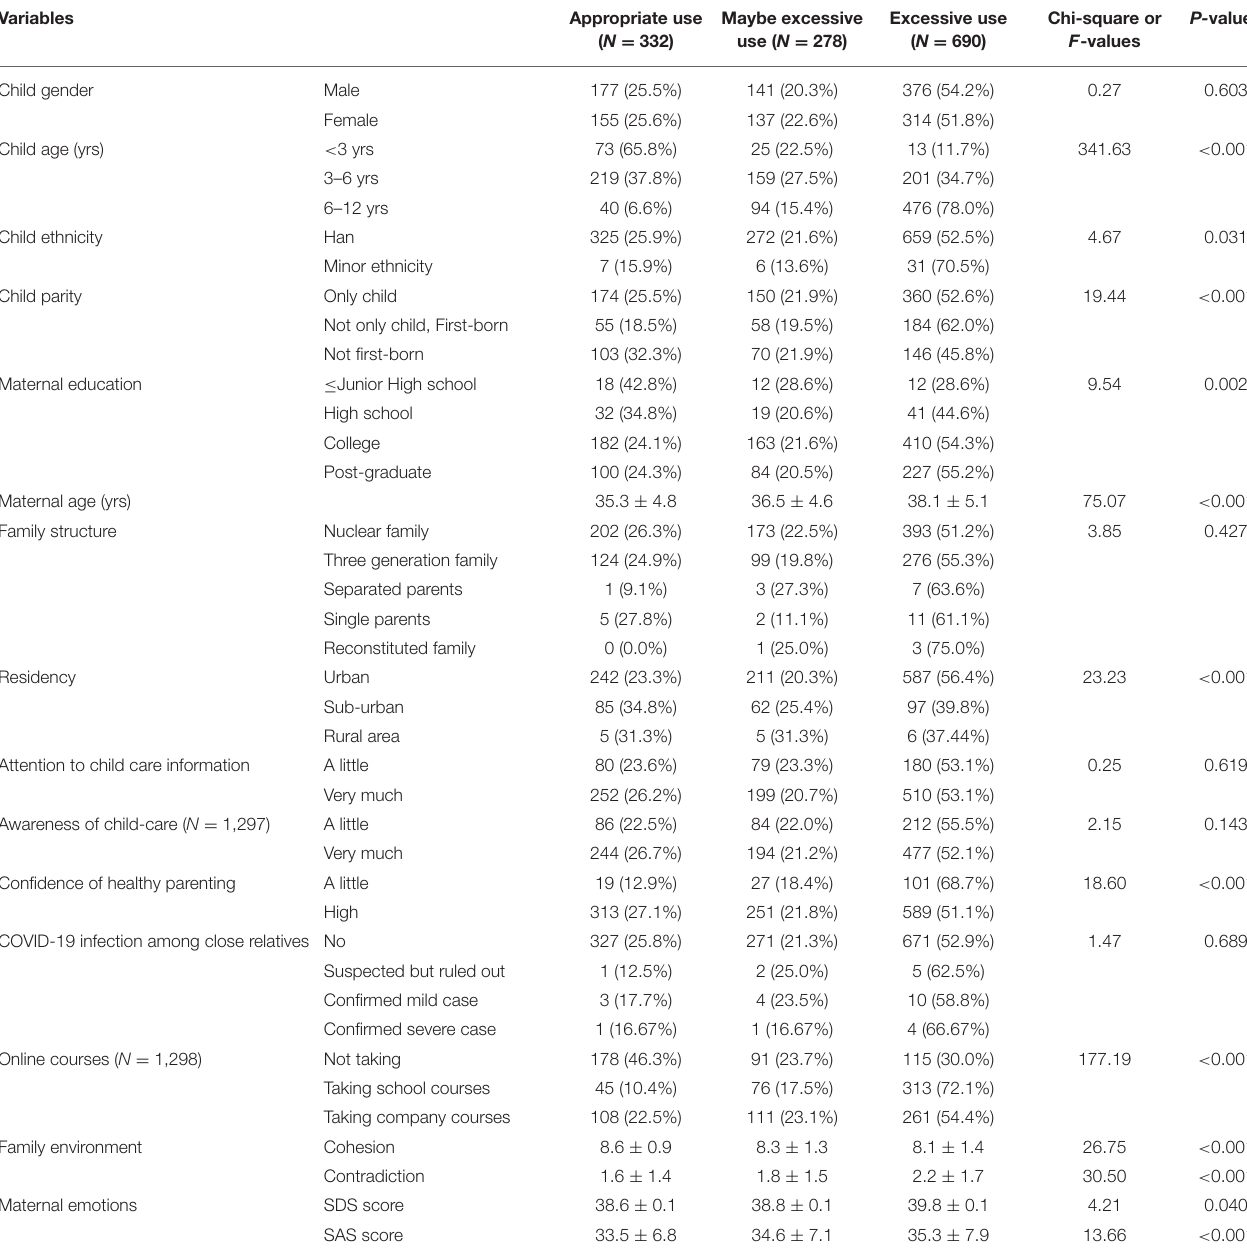
TABLE 2 | Child over-use of electronic devices during the COVID-19 pandemic [mean ± SD or N (%)].